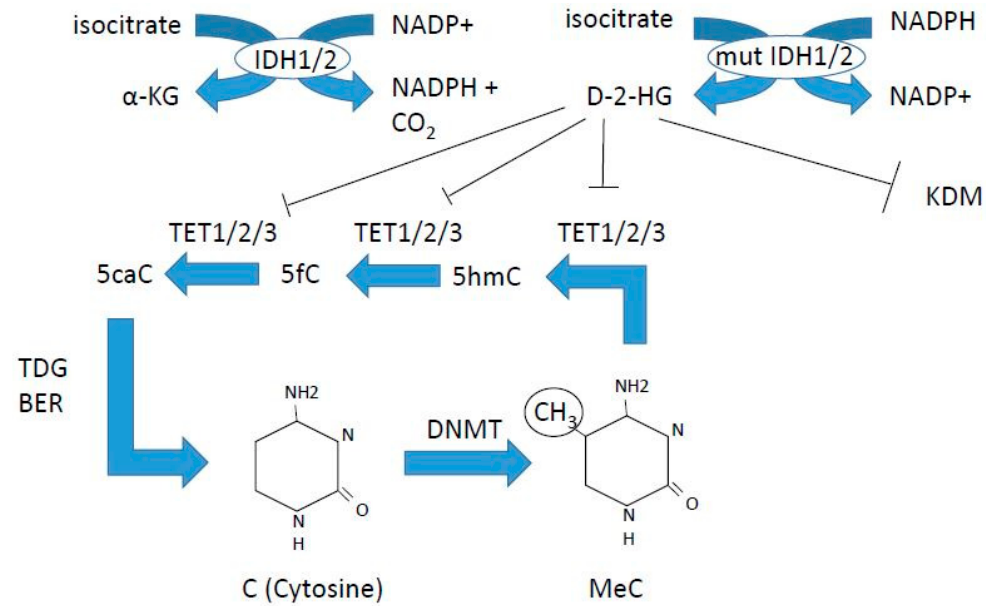
Figure 1. DNA methylation and demethylation. DNMT3A is commonly mutated in acute myeloid leukemia (AML), IDH1, 2 mutations are found in AML, and TET2 is frequently mutated in all myeloid malignancies. Azacitidine and decitabine are DNA demethylating agents, inhibiting DNA methyl transferases (DNMTs).